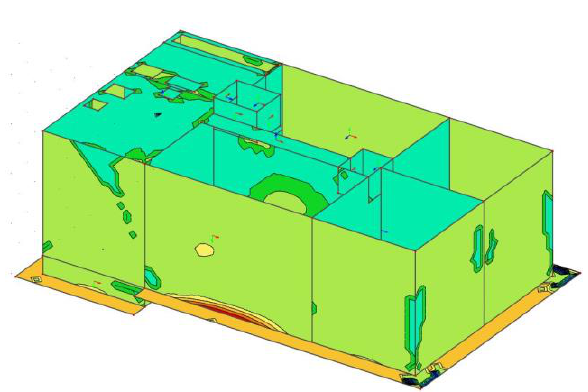
Figure 1. Necessary reinforcement